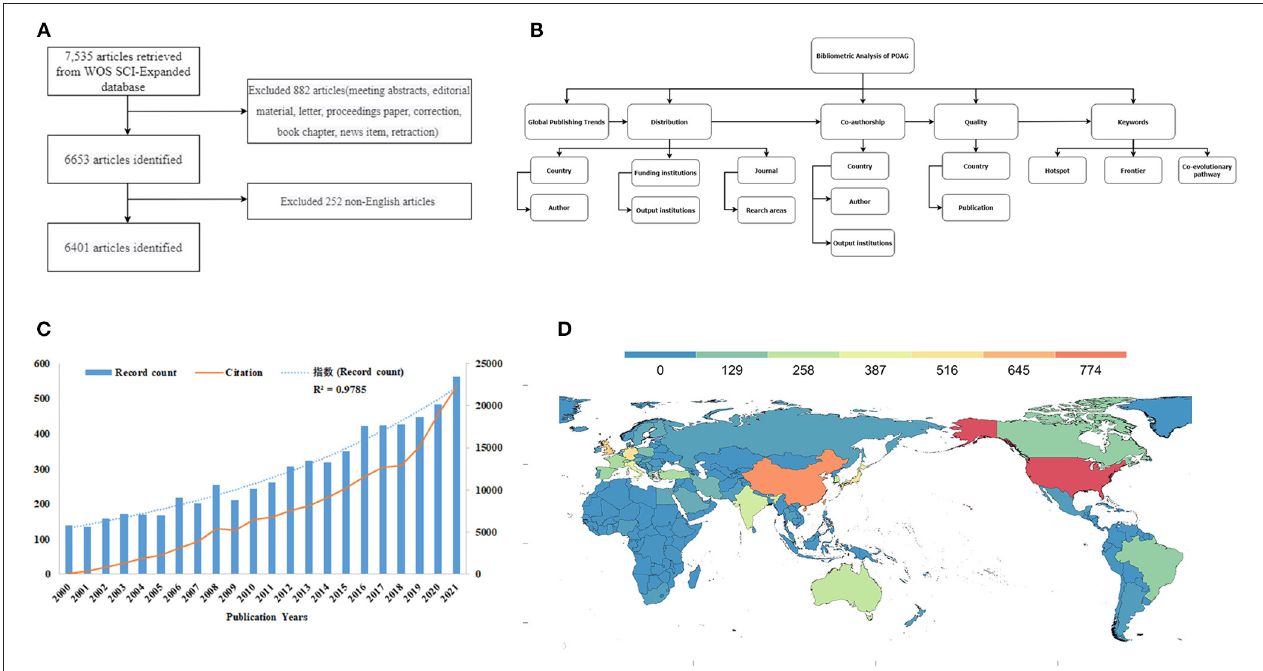
FIGURE 1 | The methods of bibliometric analysis and the trends of POAG. (A) A flowchart representing retrieval strategies for POAG articles from the WOS SCI-Expanded database and the inclusion criteria for the study; (B) The whole flow chart of bibliometric analysis for POAG in this study; (C) Trends in the growth of publications and the number of cited articles worldwide from 2000 to 2021; (D) The distribution world map of